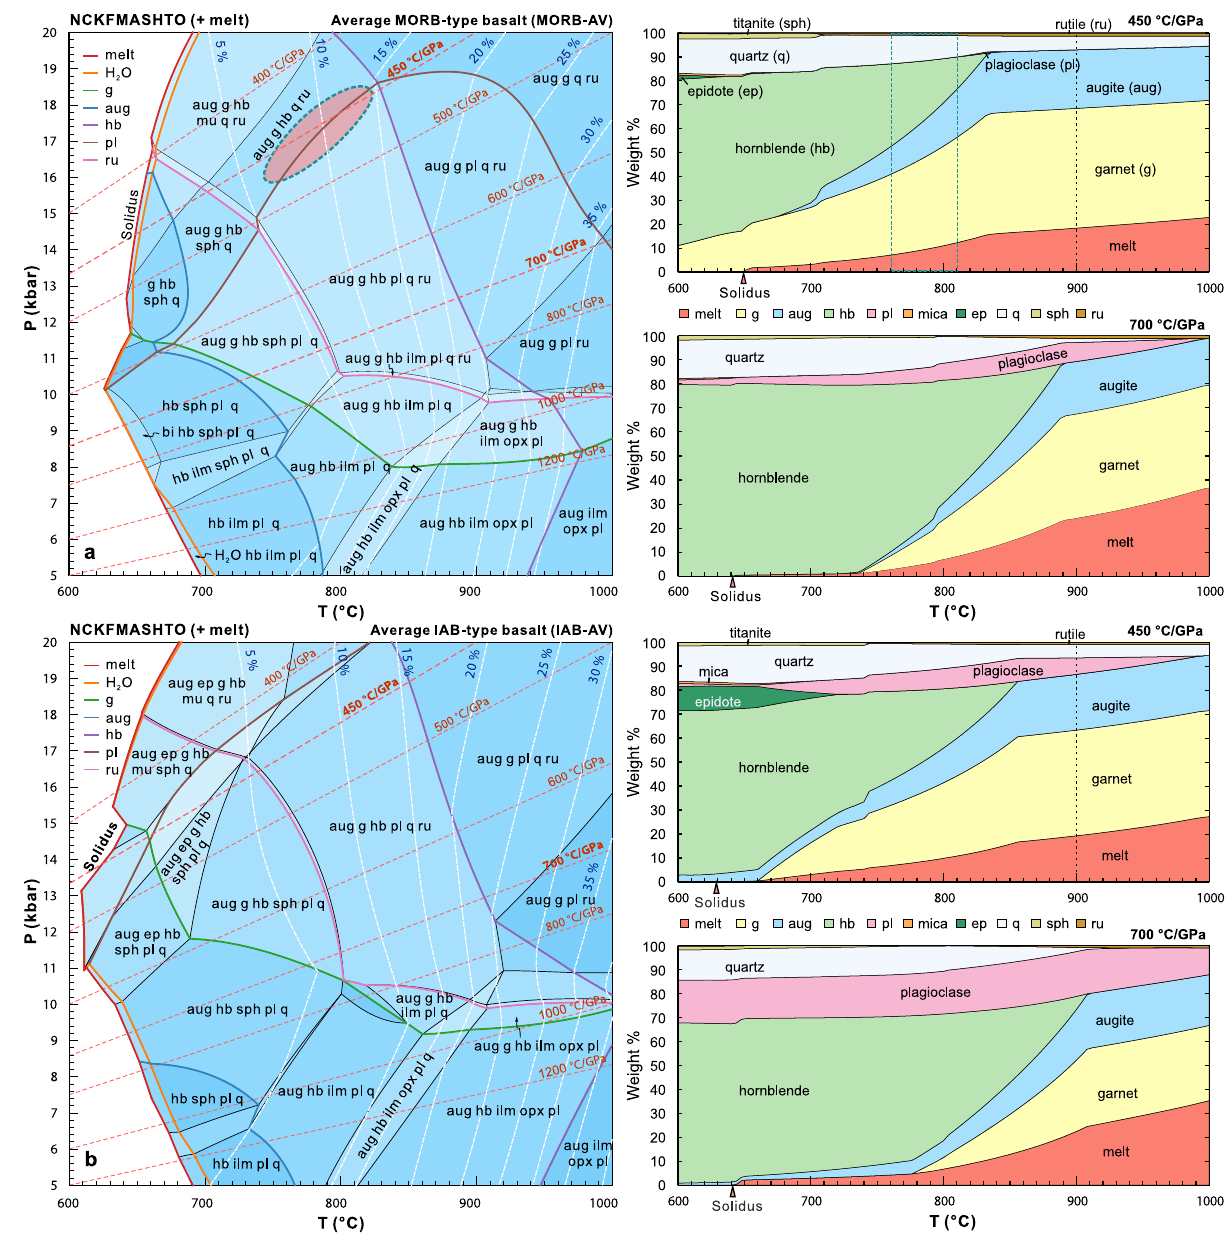
Fig. 4 | Isochemical phase diagrams (pseudosections) and calculated propor- tions (wt.%) of phases along speci fi ed thermal gradients. a Partial melting of an average MORB-type basalt (MORB-AV). b Partial melting of an average IAB-type basalt (IAB-AV). The white dashed lines and blue numbers in the phase